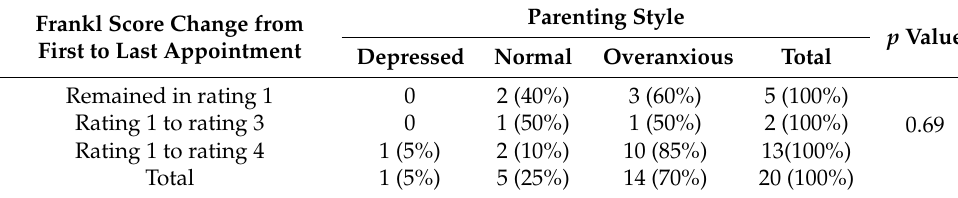
Table 7. The relationship between parenting style types and Frankl score changes from the first to last appointments.